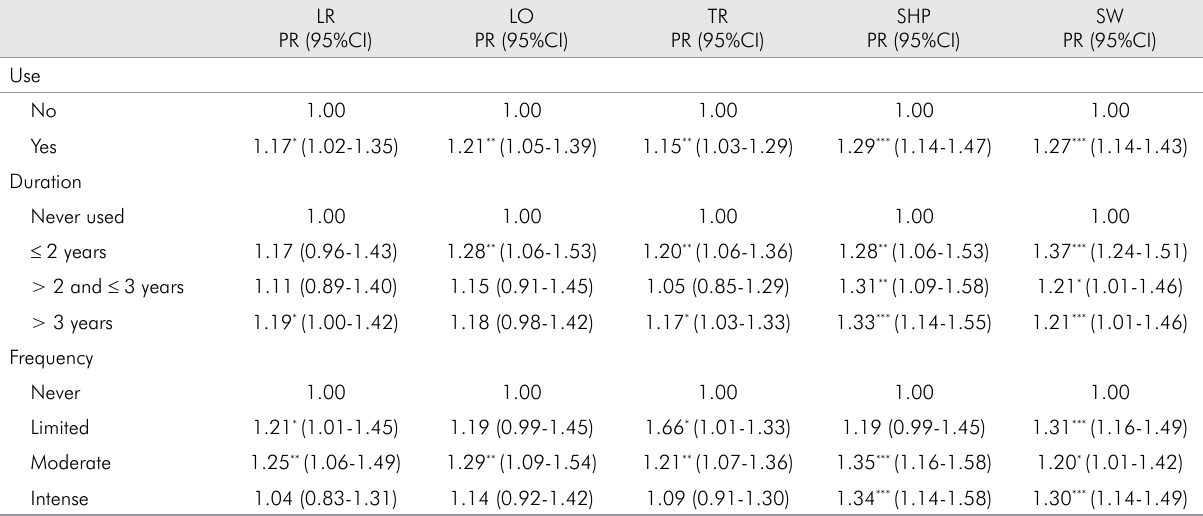
Table 4. Results of Poisson regression analysis of the association between pacifier use and the presence of oral myofunction alte- rations in preschool